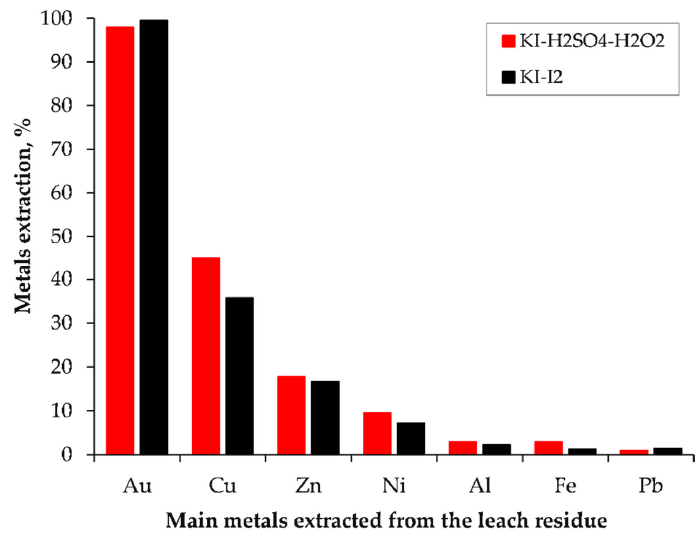
Figure 9. Comparison of the efficiency of metals extraction via iodide leaching and iodine–iodide leaching at pulp density of 50 g/L.